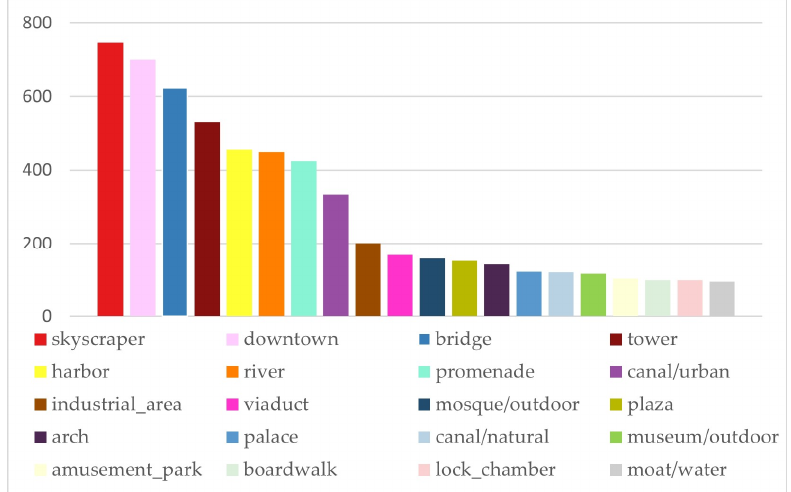
Figure 10. Top 20 top-1 to top-5 predicted image classification results.